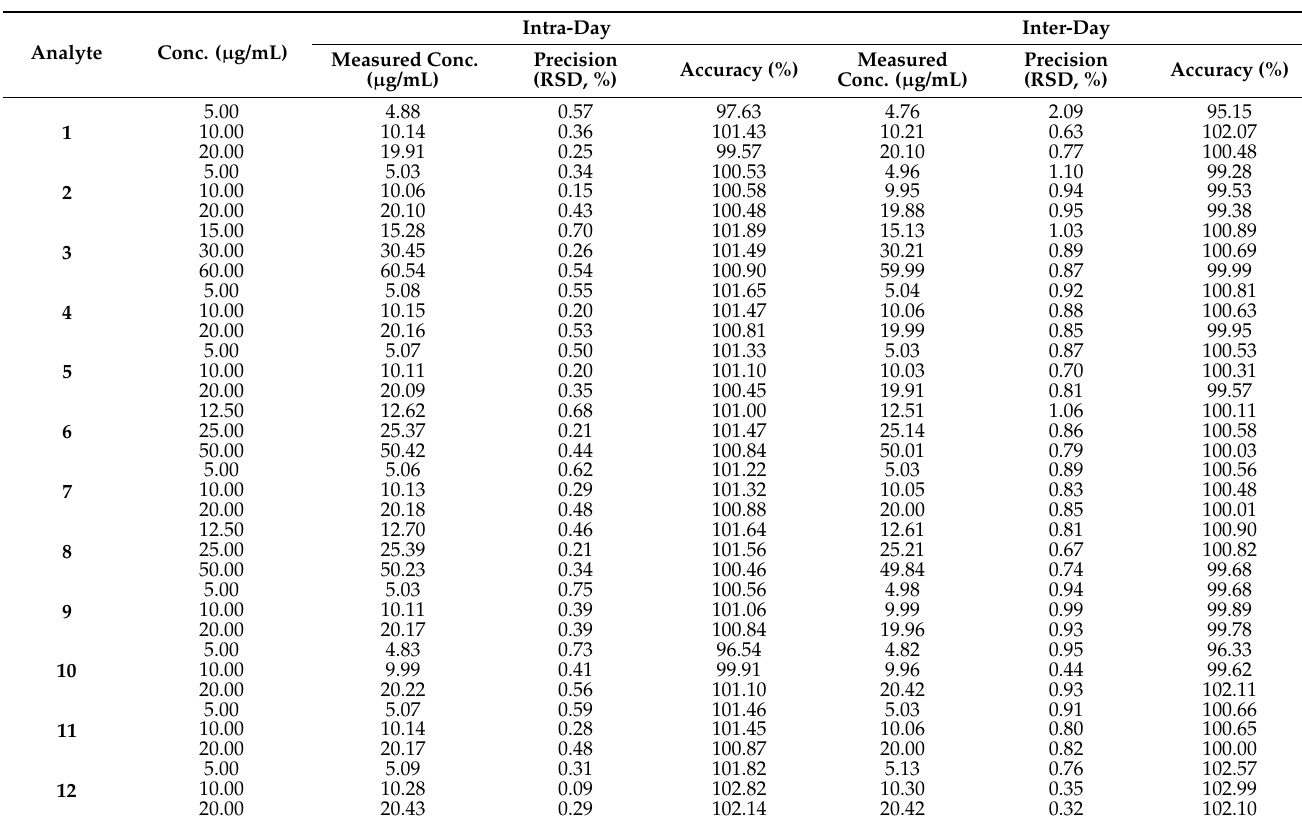
Table 5. Precision data for the 12 markers determined using the HPLC method ( n = 5).